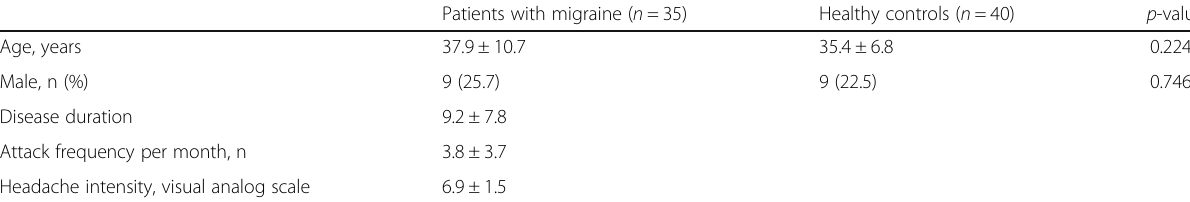
Table 1 Clinical characteristics of the patients with migraine and healthy controls Patients with migraine ( n =